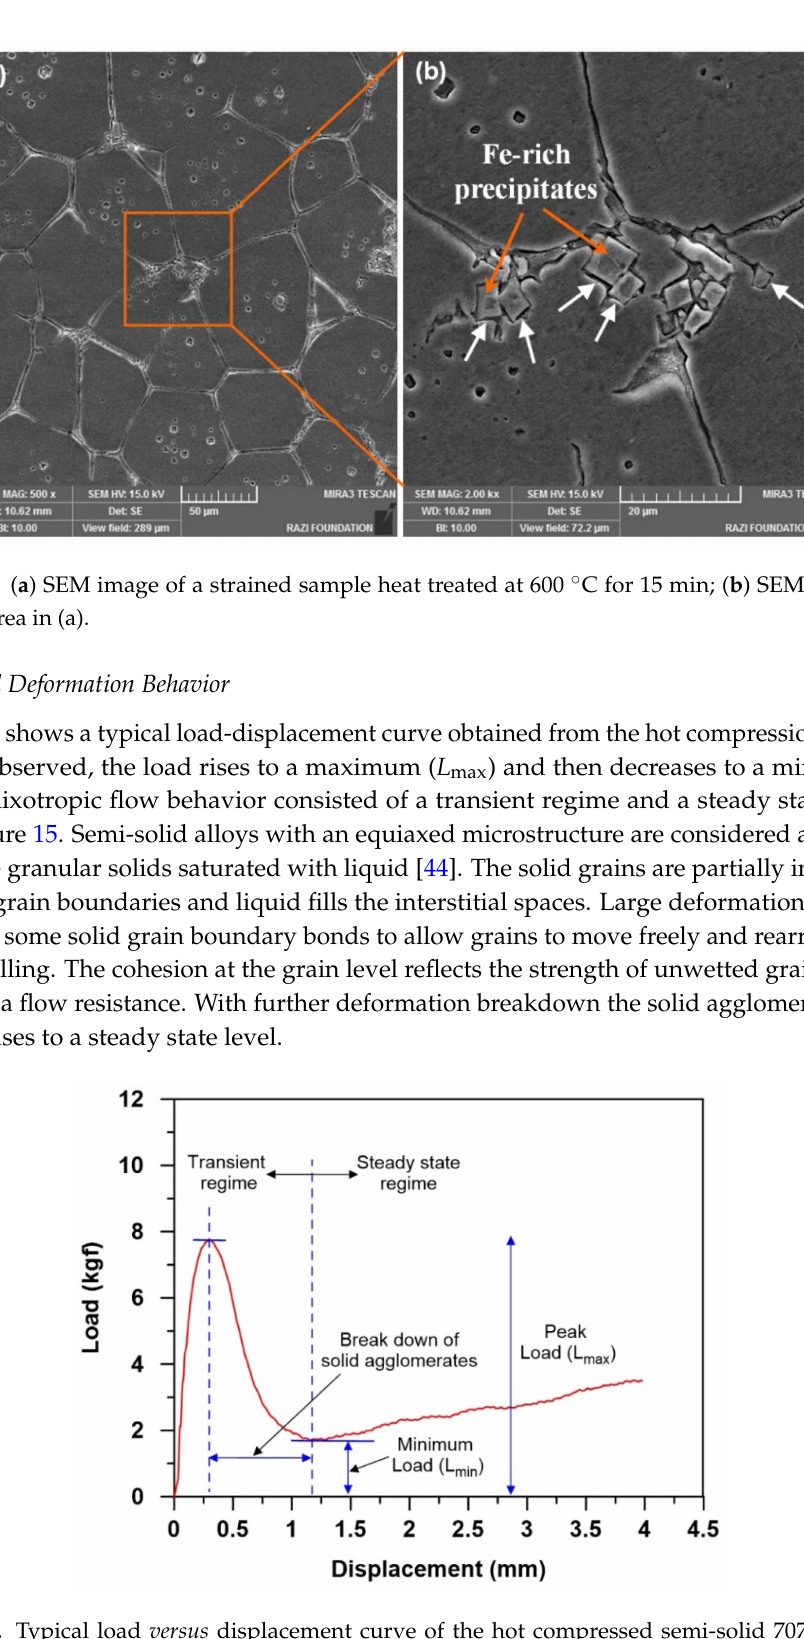
Figure 15. Typical load versus displacement curve of the hot compressed semi-solid 7075 sample (isothermally treated at 600 ˝ C for 15 min) at 600 ˝